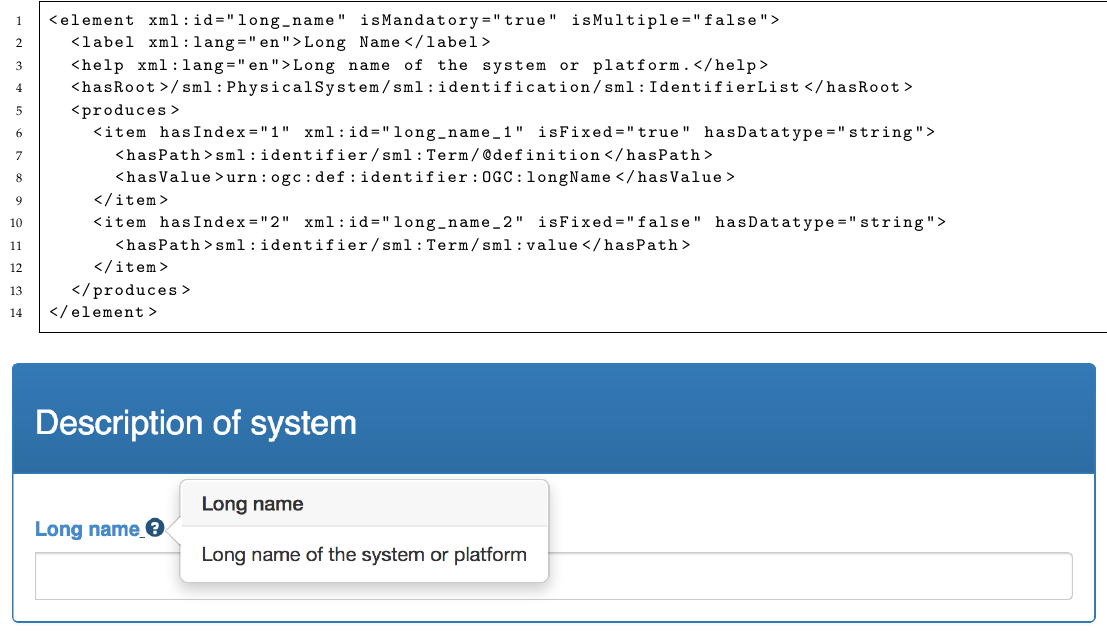
Figure A1. EDI web form rendering of the excerpt in Listing